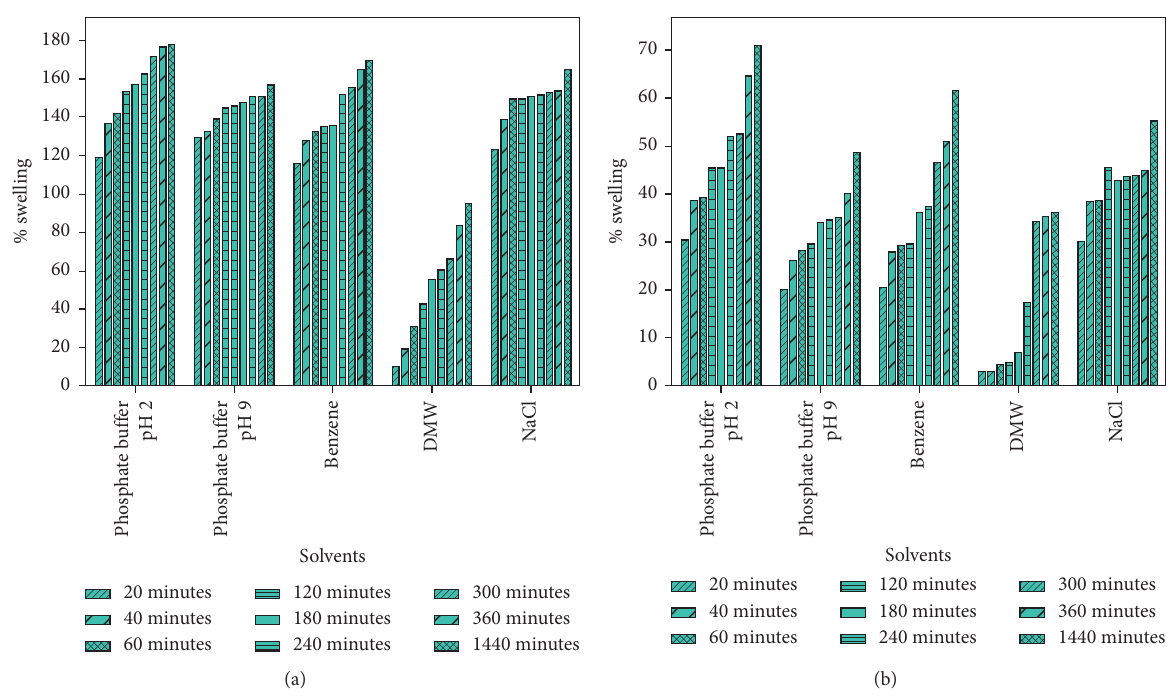
Figure 5: Swelling studies for (a) pinus-raw and (b) pinus-g-(AN/EA).